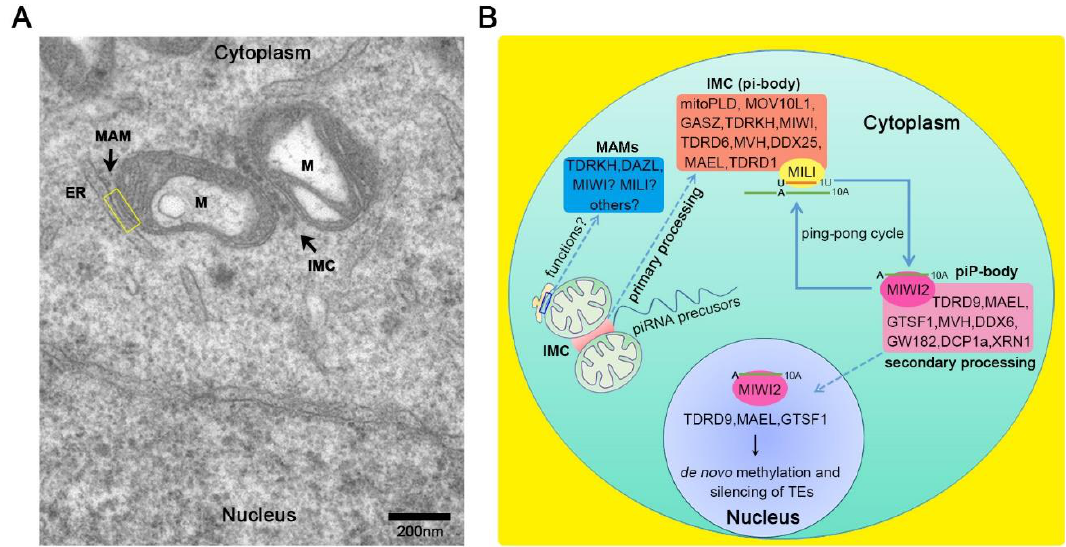
Figure 1. The ultra-structures, components, and functions of intermitochondrial cement (IMC) and mitochondria-associated ER membranes (MAMs) in male germ cells are summarized. ( A ) TEM image showing the morphology of IMC and MAMs (yellow rectangle area) in spermatocytes. M: mitochondria; ER: endoplasmic reticulum. ( B ) The summary of the components and functions of IMC (also called pi-bodies), piP-bodies, and MAMs in Piwi-interacting RNA (piRNA) biogenesis during mouse spermatogenesis. After piRNA precursors are exported from the nucleus, they process by factors located in the IMC into piRNA intermediates, then load to MILI protein and are cleaved, generating mature primary piRNA with 1U signature. The MILI-bound piRNA then engages in the ping-pong cycle leading to the cleavage of complementary antisense transcripts, producing secondary piRNA with 10A signature, and then are loaded to either MILI or MIWI2. Loading of MIWI2 with secondary piRNA induces its translocation into the nucleus where it functions in the methylation and silencing to transposable elements (TEs) together with other nuclear factors. However, the components of MAMs and how MAMs regulate the piRNA pathway still need to be further explored. Non-standard abbreviations in this review are shown: IMC, intermitochondrial cement; CB, chromatoid body; MAMs, mitochondria-associated ER membranes; TEM, transmission electron microscope; MVH, mouse vasa homolog; TDRD1 / MTR-1, Tudor domain-containing 1 / Mouse Tudor repeat-1; TDRD6, Tudor domain-containing 6; MOV10L1, Moloney leukemia virus 10 like 1; TDRKH, Tudor and KH domain-containing protein.